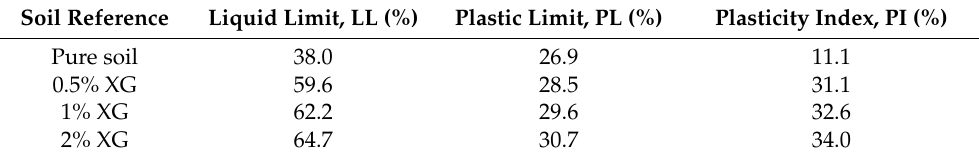
Table 1. Results of Atterberg limits